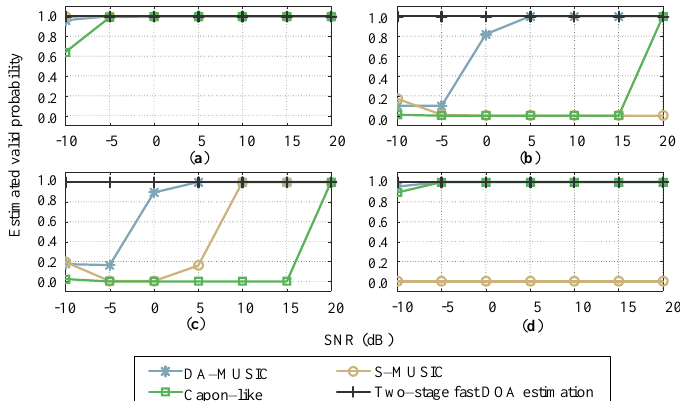
Figure 6. Estimated valid probability versus SNR for each target: ( a ) Target 1, ( b ) Target 2, ( c ) Target 3, and ( d ) Target 4.